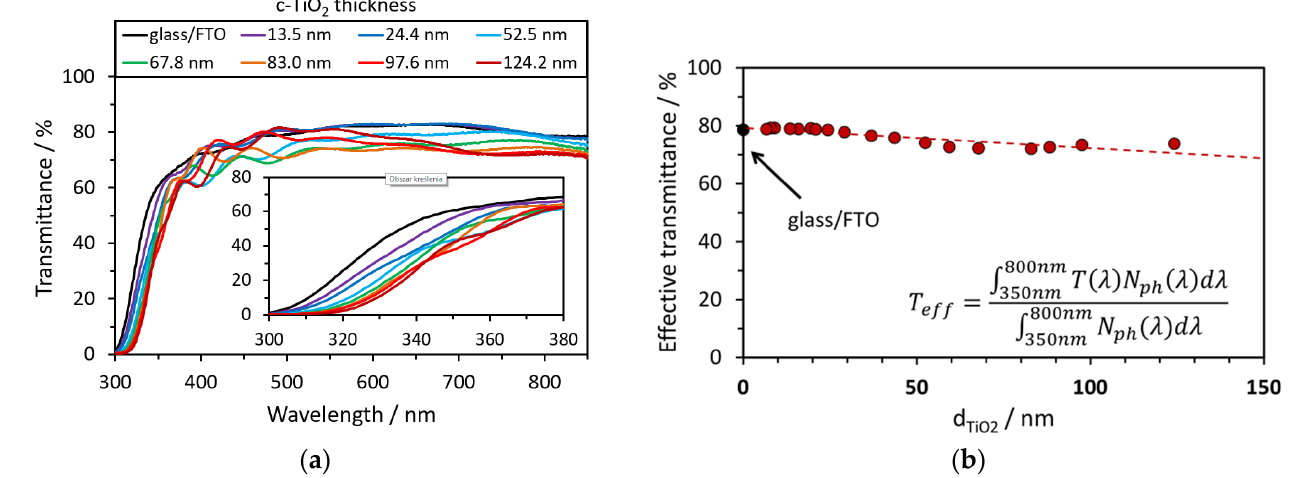
Figure 3. ( a ) Transmittance of glass/FTO/c-TiO 2 of different thicknesses obtained from the Ti(acac) 2 OiPr 2 solution in 1-BuOH; ( b ) the dependence of the effective transmittance on the thickness in glass/FTO/c-TiO 2 . Effective transmittance T eff was calculated for the range of wavelengths λ from 350 to 800 nm, where T is the transmittance, and N ph is the radiant flux.